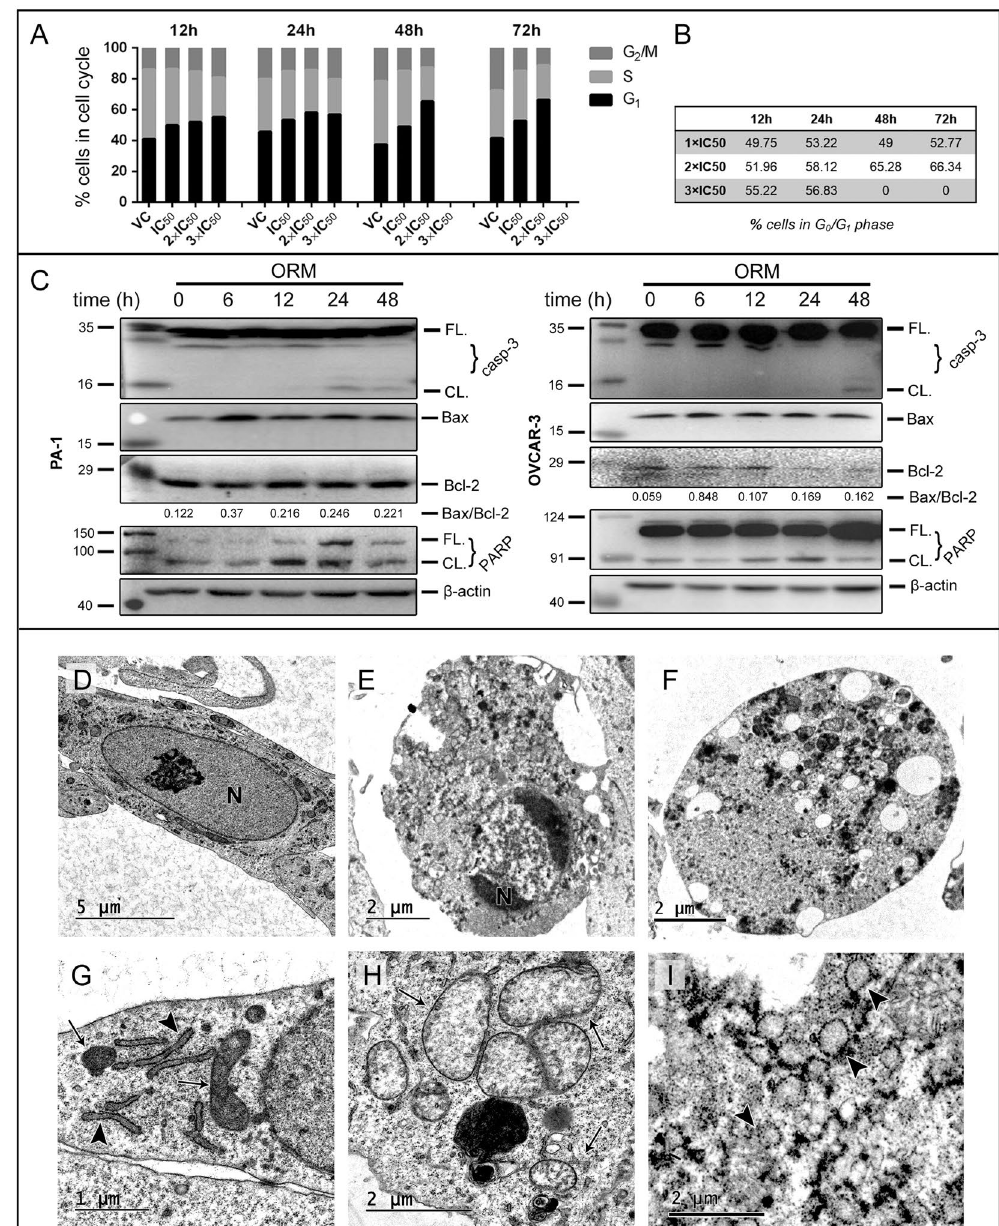
Figure 3. ORM induces caspase-dependent apoptosis. ( A ) Cell cycle analysis by flow cytometry of PA-1 cells post-treatment with ORM for indicated time (12 h, 24 h, 48 h & 72 h) and dose (1, 2 & 3 × IC 50 ). ( B ) Percentage of cells in G 0 /G 1 phase calculated for each time and dose. ( C) PA-1 and OVCAR-3 cells were treated with ORM IC 50 dose for indicated time periods and immunoblotted for apoptotic markers caspase 3, PARP, Bcl-2 and Bax. ( D ) Representative electron micrograph of control PA-1 cytoplasm, ( E ) early apoptotic cell (following treatment of IC 50 dose of ORM) characterized by nuclear condensation, and ( F ) late apoptotic cell showing severe vacuolation. ( G ) Control mitochondria and ER of PA-1 cells; ( H ) swollen mitochondria and, ( I ) swollen ER post-treatment. N = nucleus, arrowheads = RER, arrows =